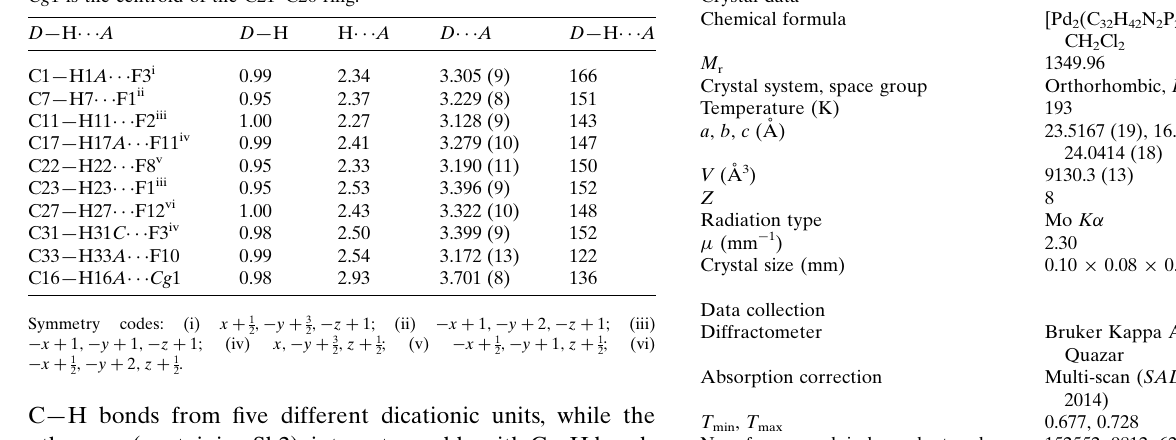
C—H bonds from five different dicationic units, while the